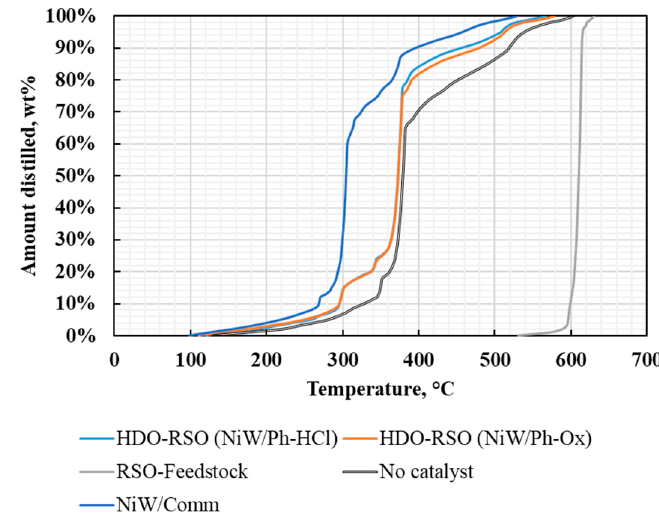
Figure 4. Simulated distillation (SimDis) for the deoxygenation (DO) products and feedstock. For the HDS tests, an elemental analysis for % C, H, N, and S of the organic liquid phase was performed, in which similar results were obtained for the hydrogen and carbon contents (Table 6).